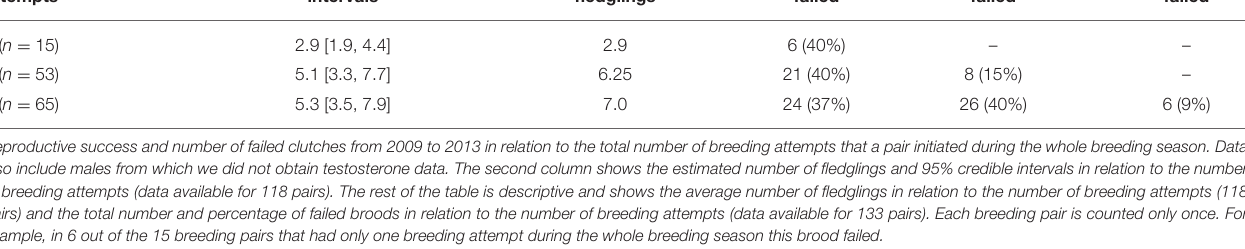
TABLE 1 | Breeding attempts and reproductive success. Number of